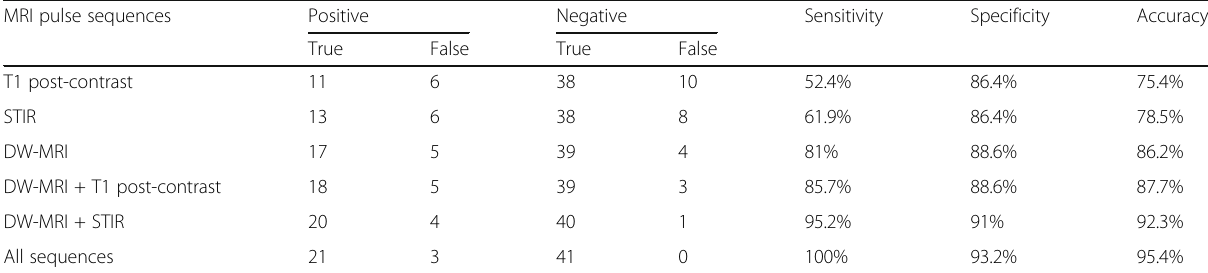
Table 5 Detection of collections defined as cavities of > 3 mm in diameter using different MRI pulse sequences MRI pulse